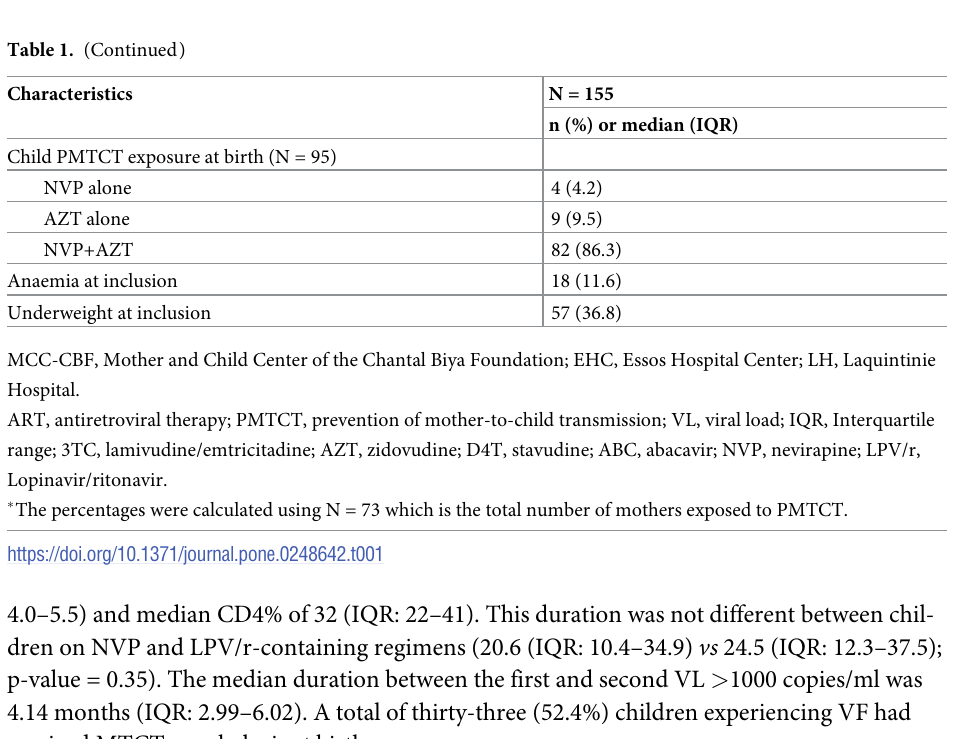
4.0–5.5) and median CD4% of 32 (IQR: 22–41). This duration was not different between